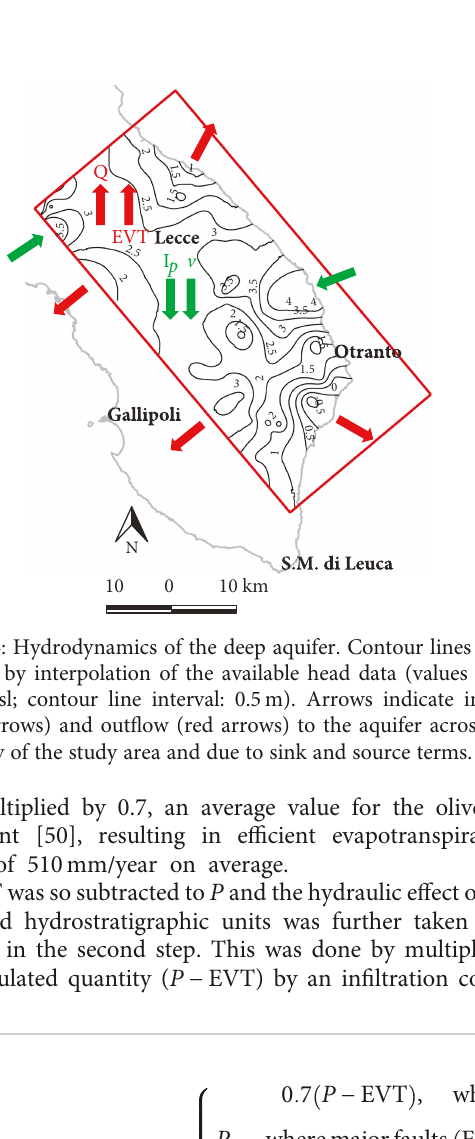
(modi fi ed after De irf